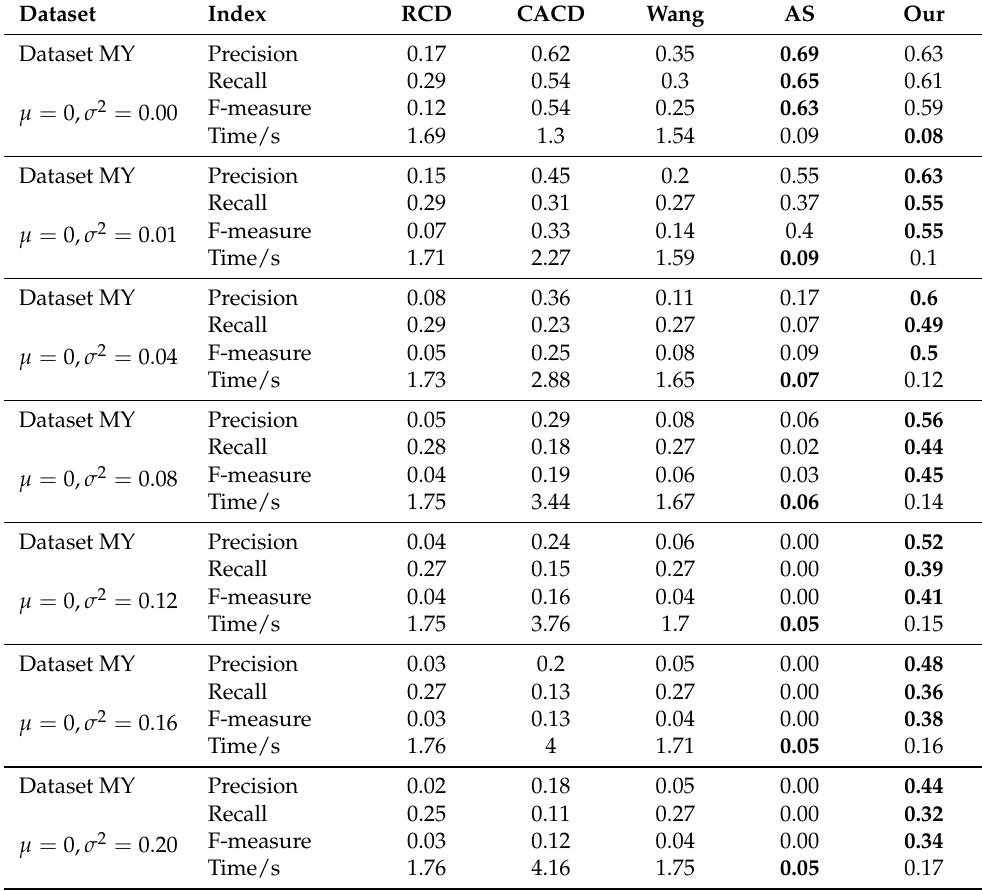
Table 2. Result on dataset